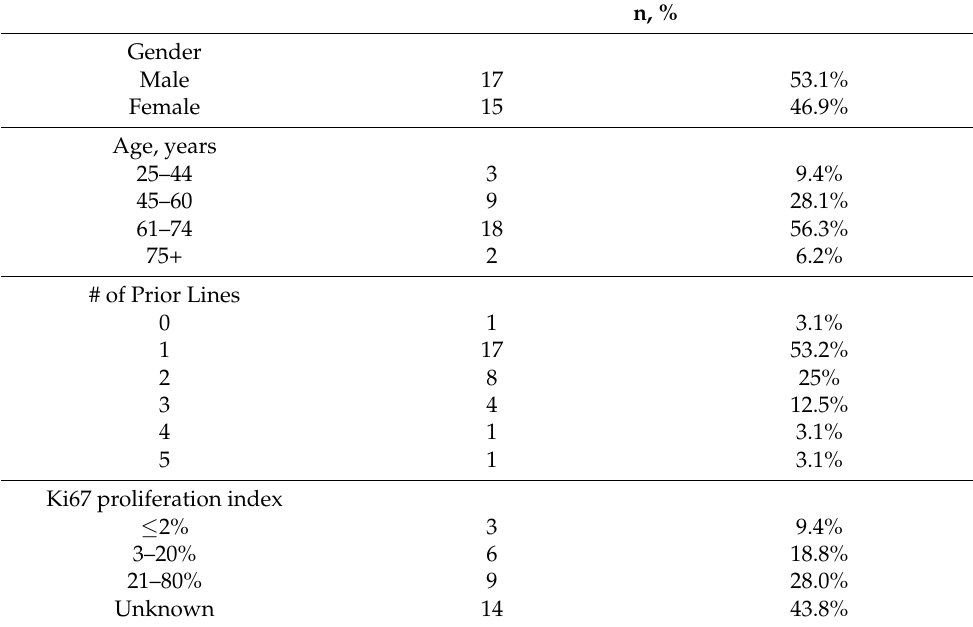
Table 1. Patient demographics and tumor characteristics.